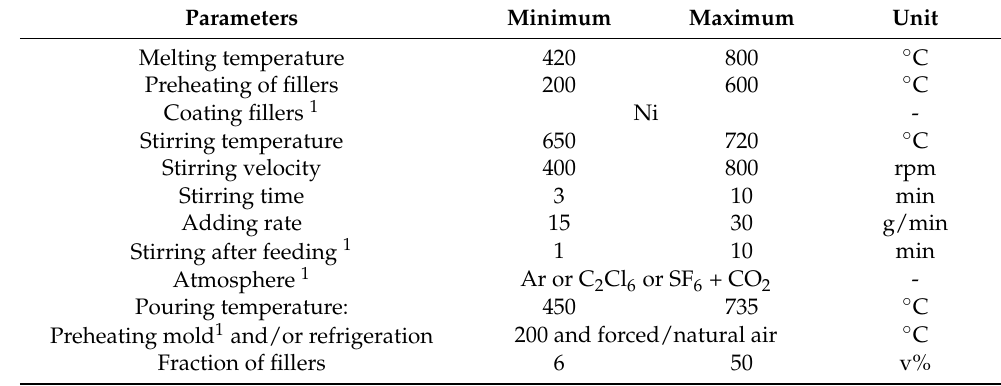
Table 2. Range of values of the parameters governing the conventional stir casting (CSC) process. Parameters Minimum